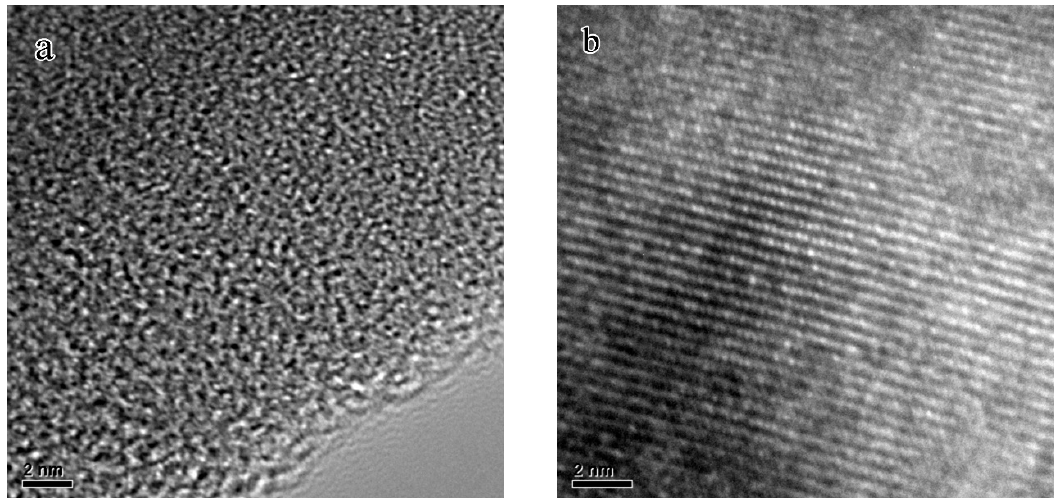
Figure 5. HRTEM images of K-based GP calcined at 1400 °C for 3 h: ( a ) amorphous glassy phase structure; ( b ) the crystallized leucite structure.